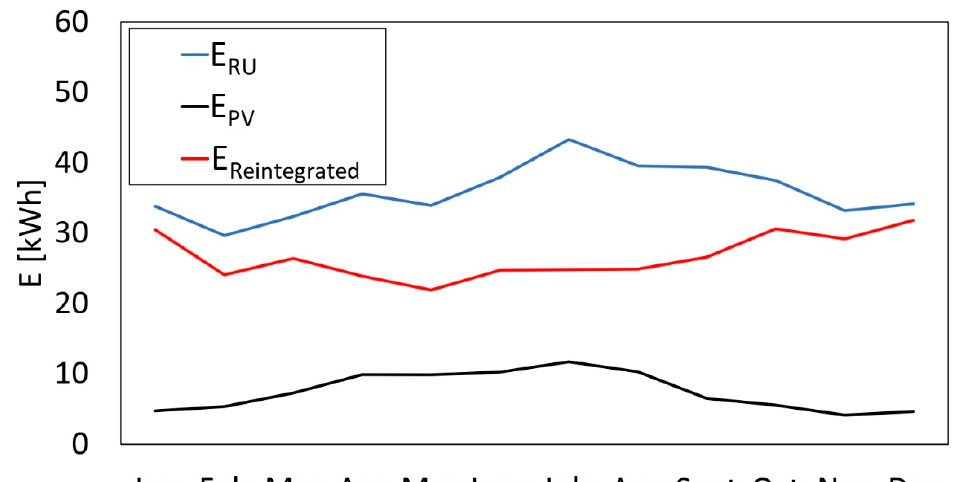
Figure 9. Monthly electricity absorbed by the refrigeration unit, produced by the PV system, and reintegration from the grid.